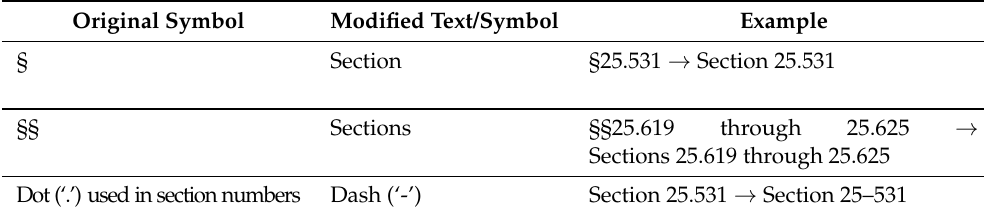
Table 4. Symbols that were modified for corpus creation [59].